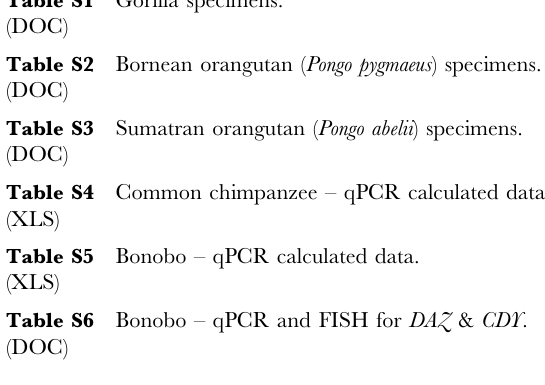
Table S7 Common chimpanzee – qPCR and FISH for DAZ & CDY. (DOC) Table S8 Primer